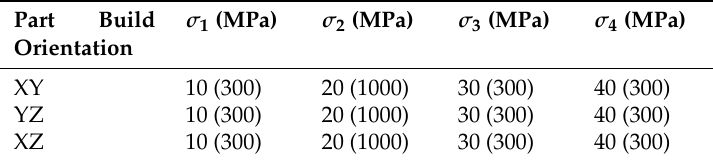
Table 4. Sample design matrix for the stress relaxation tests. Loading time, in minutes, appears in